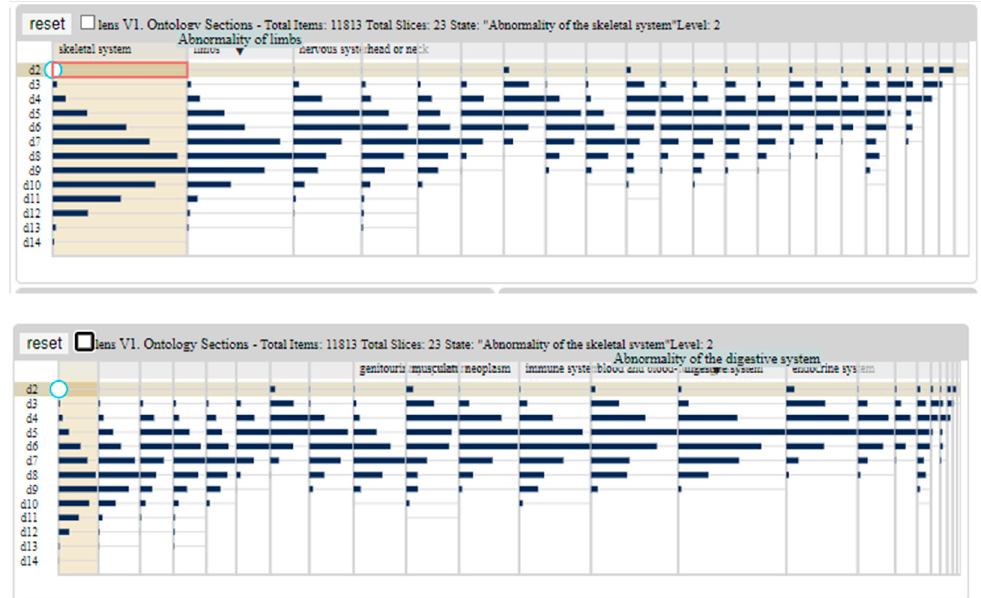
Figure 11. A depiction of the distortion technique within the Ontology Sections Panel. This technique can be adjusted through interaction. This is achieved by holding the Shift key while directing the mouse over a section. Releasing the Shift key will end the interaction event and lock in the sizing adjustments. If adjustments have been made, yet the user would like to return to the original distortion scaling, we have provided a Reset button at the top left corner of the Ontology Sections Panel.